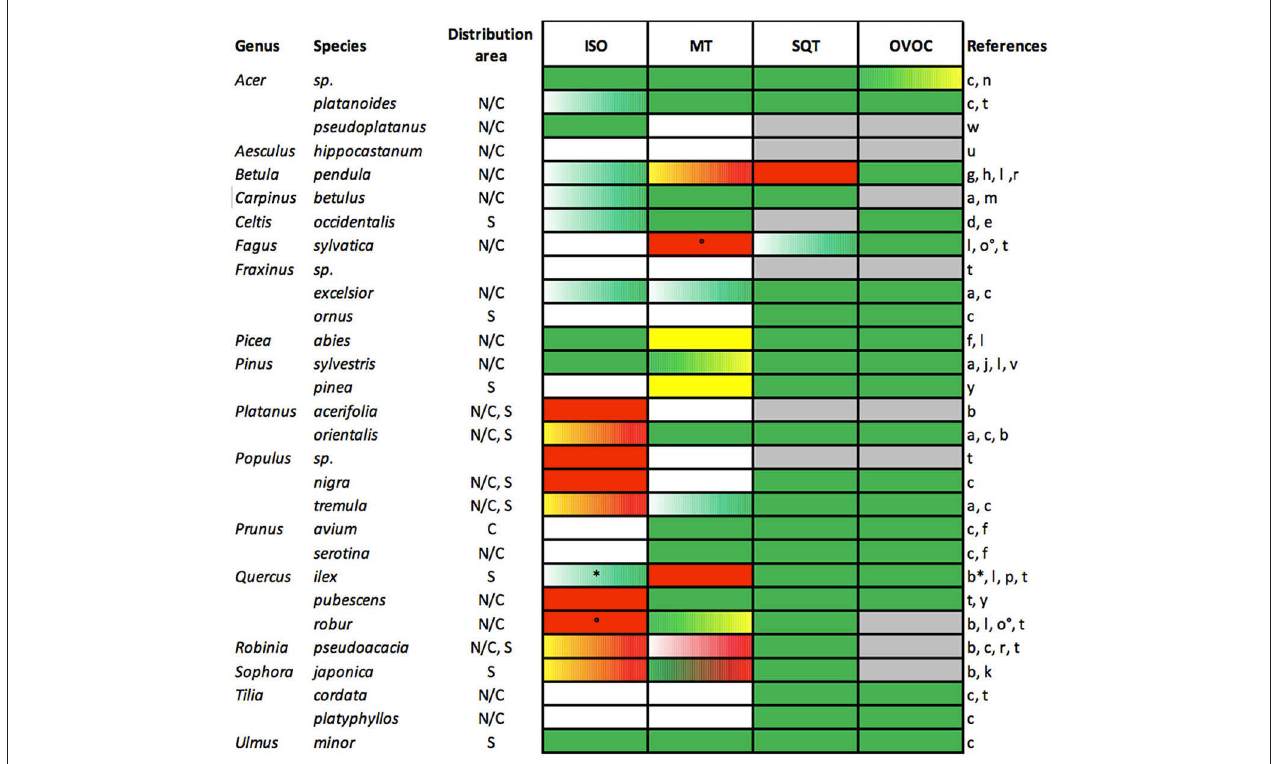
FIGURE 2 | Standard emission potentials ( µ g g DW − 1 h − 1 ; at 30 ◦ C leaf temperature and 1,000 µ mol m − 2 s − 1 PPFD) of isoprene (ISO), monoterpene